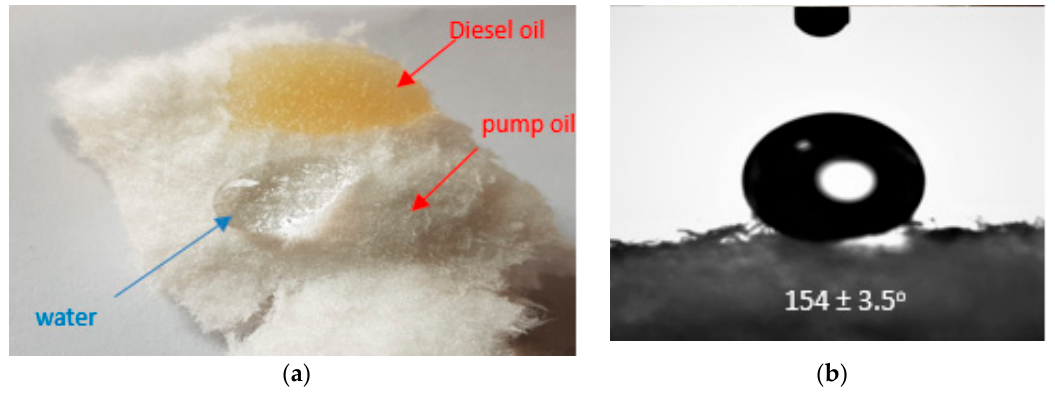
Figure 6. ( a ) Water/oil adsorption interaction and ( b ) the water contact angle for a functionalised cigarette filter.